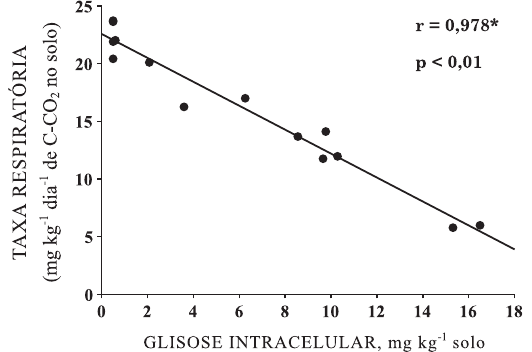
Figura 3. Correlação metabólica entre o teor de glicose intracelular e a taxa respiratória do solo. * correlação significativa a 1 % (n =